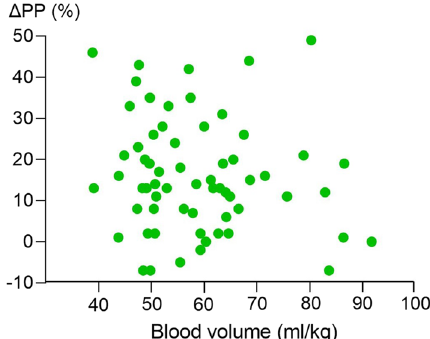
Fig. 2 Change in pulse pressure (ΔPP) following a passive leg raising test in relation to blood volume